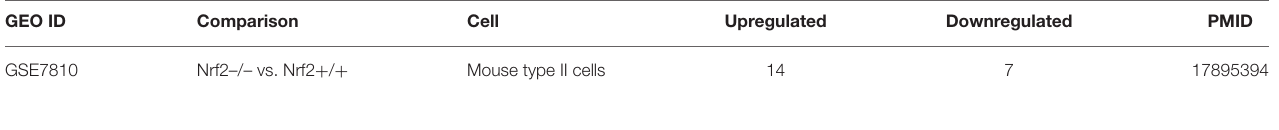
TABLE 8 | Reactive oxygen species (ROS) negative regulator Nrf2 deficiency microarray (GSE7810) in the National Institutes of Health (NIH)–National Center for Biotechnology Information (NCBI)–Gene Expression Omnibus (GEO) datasets database (https://www.ncbi.nlm.nih.gov/gds/) was collected to analyze the expression changes of organelle interactions and vesicle-related genes ( p < 0.05, |logFC| >